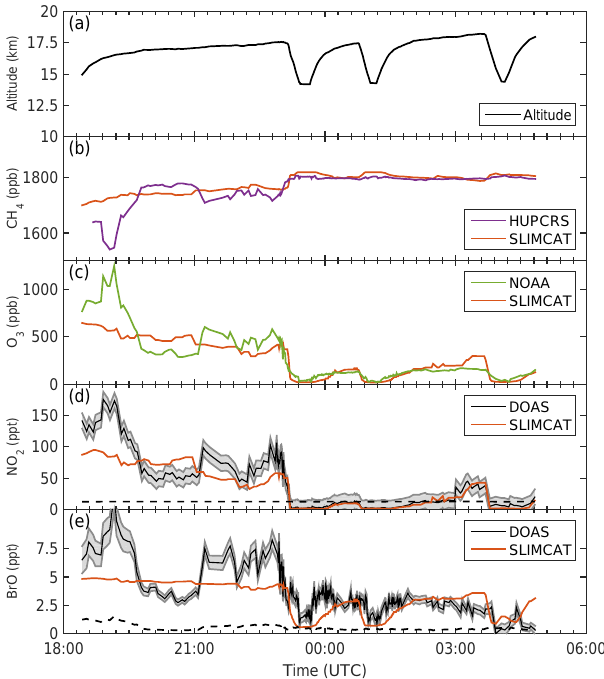
Figure 13. Same as Fig. 12, but vertically adjusting Tomcat/Slimcat-modeled predictions with NOAA-measured O 3 to agree in a least squares sense. The forcing is performed by interpolating the predicted profile of the gases and subsequent vertically shifting the whole packages of predicted gases until mea- sured and modeled O 3 and CH 4 agree best. Typical vertical shift range from 0 to 1000m, the latter being about the vertical spacing of the Tomcat/Slimcat height levels. The errors of the mini-DOAS NO 2 and BrO are shown as gray areas in panels (d) and (e) . The dashed lines in panels (d) and (e) represent the detection limits of the mini-DOAS